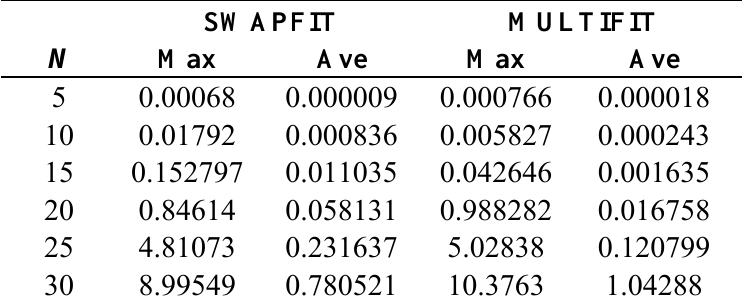
Table 3. Summary of algorithm running times (s).